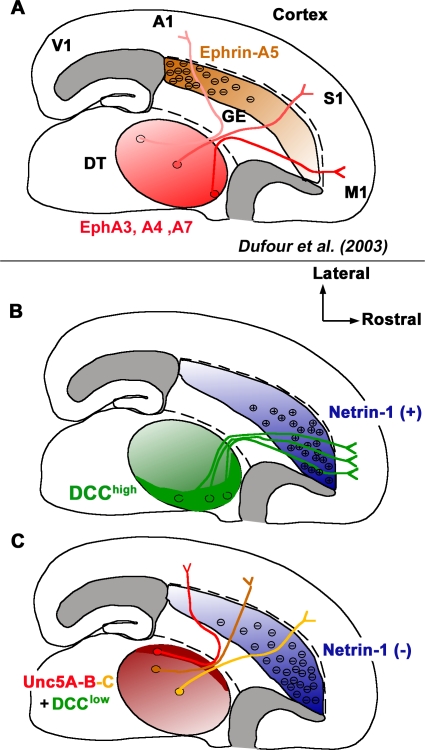
Model of the Role of Netrin-1 Signaling in the Topography of Thalamocortical Projections in the Ventral TelencephalonSchemas summarizing previous [11] and present findings regarding the axon guidance cues controlling the topographic sorting of TC axons in the VTel.(A) High rostromedial and low caudolateral gradient of EphA receptors (EphA3-4-7) mediate chemopulsion of rostromedial DTh (DT) axons to the high-caudal to low-rostral gradient of ephrin-A5 in the VTel.(B and C). In the present study, we demonstrate that a high-rostral to low-caudal gradient of Netrin-1 in the VTel plays a critical role in the topographic projection of DTh axons in the VTel. We show that the rostromedial domain of the DTh expresses high levels of DCC and that the caudolateral domain of the DTh expresses low levels of DCC, which is required both for the attraction of DTR axons and the repulsion of DTC axons to the Netrin-1–rich rostral domain of the VTel. We also show that Unc5A and B are expressed preferentially in the caudolateral domain of the DT, and Unc5C is expressed in a high-caudolateral to low-rostromedial gradient in the DTh. Finally, we provide evidence that (1) Unc5A/C are required for the repulsion of caudal DTh axons from the Netrin-1–rich domain of the VTel, but (2) they do not play any significant role in the projection of rostromedial DTh axons, and (3) that overexpression of Unc5C in DTR axons is sufficient to convert their outgrowth into DTC outgrowth, i.e., repulsion away from the Netrin-1–rich rostral domain of the VTel.A1, primary auditory area; GE, ganglionic eminence; M1, primary motor area; S1, primary somatosensory area; V1, primary visual area.